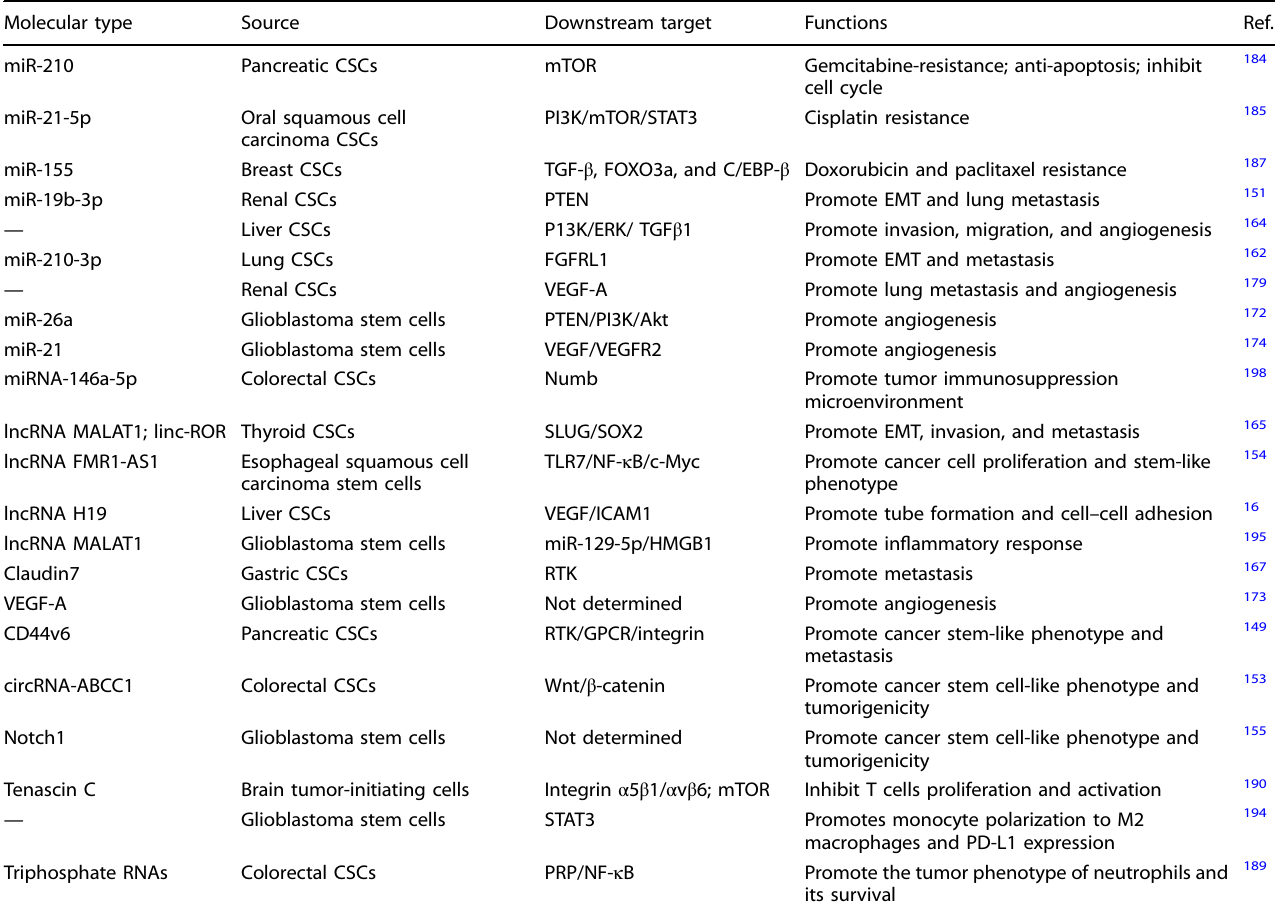
Table 3. Functions of cargo in different types of cancer stem cells-derived EVs Molecular